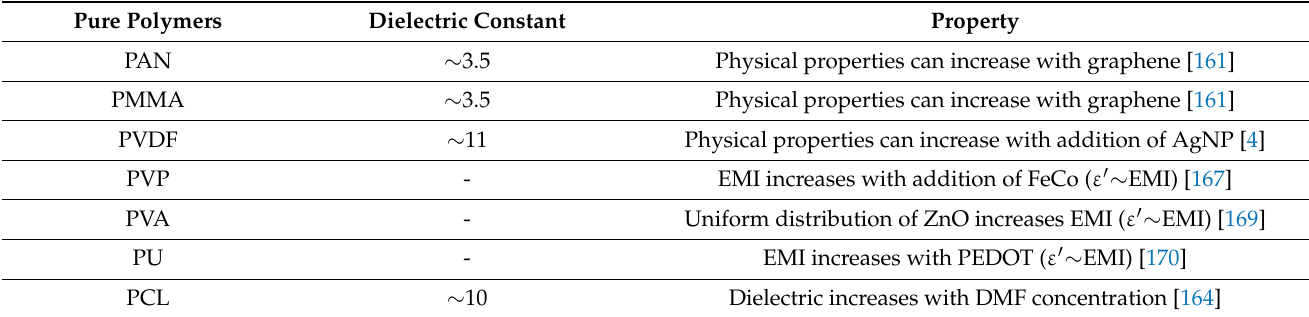
Table 4. Dielectric properties of different